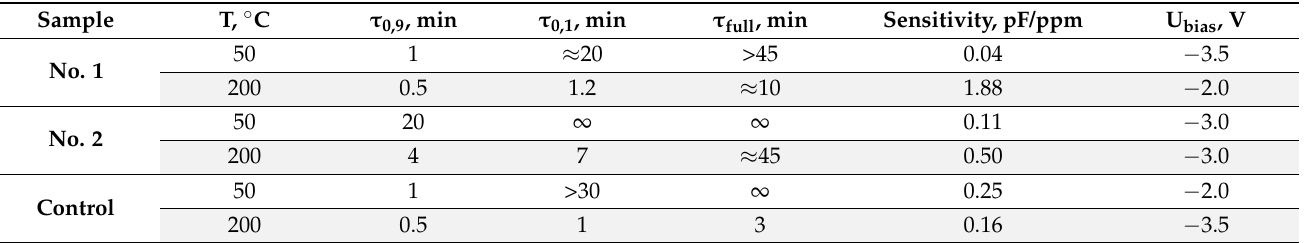
Table 1. Sensors’ response times under the act of 1000 ppm H 2 and relative sensitivity level corre- sponding to the U bias value received by using the Board